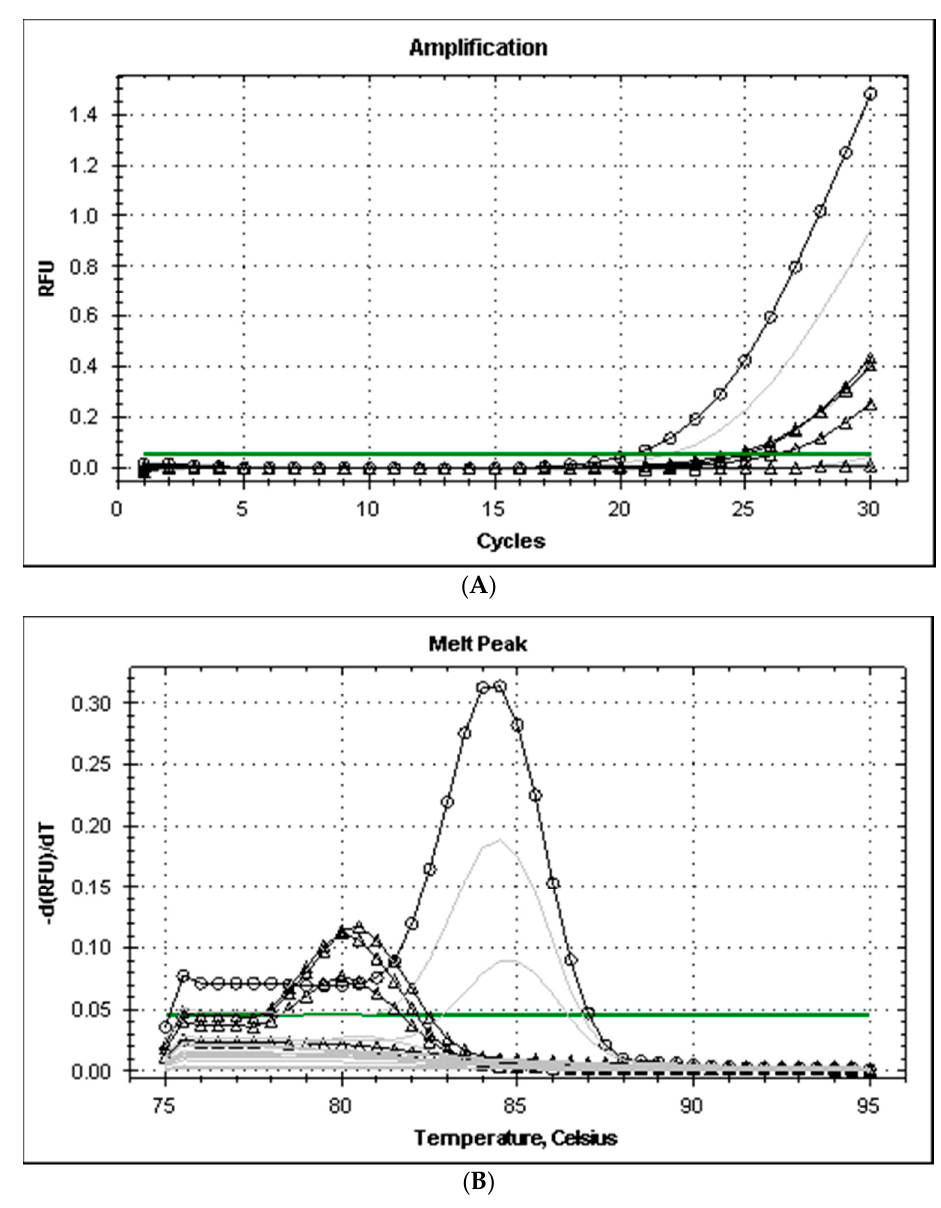
Figure 1. Amplification plot (A) and melt curves (B) from rt-PCR of histidine decarboxylase genes of Gram-negative bacteria (primers hdc-dp). Legend: annealing temperature for gradient PCR amplification ranged from 49 (dark lines) to 53°C (grey lines); lines with symbols Δ and ○ correspond to Pdd (3 strains)and M. morgani , respectively.